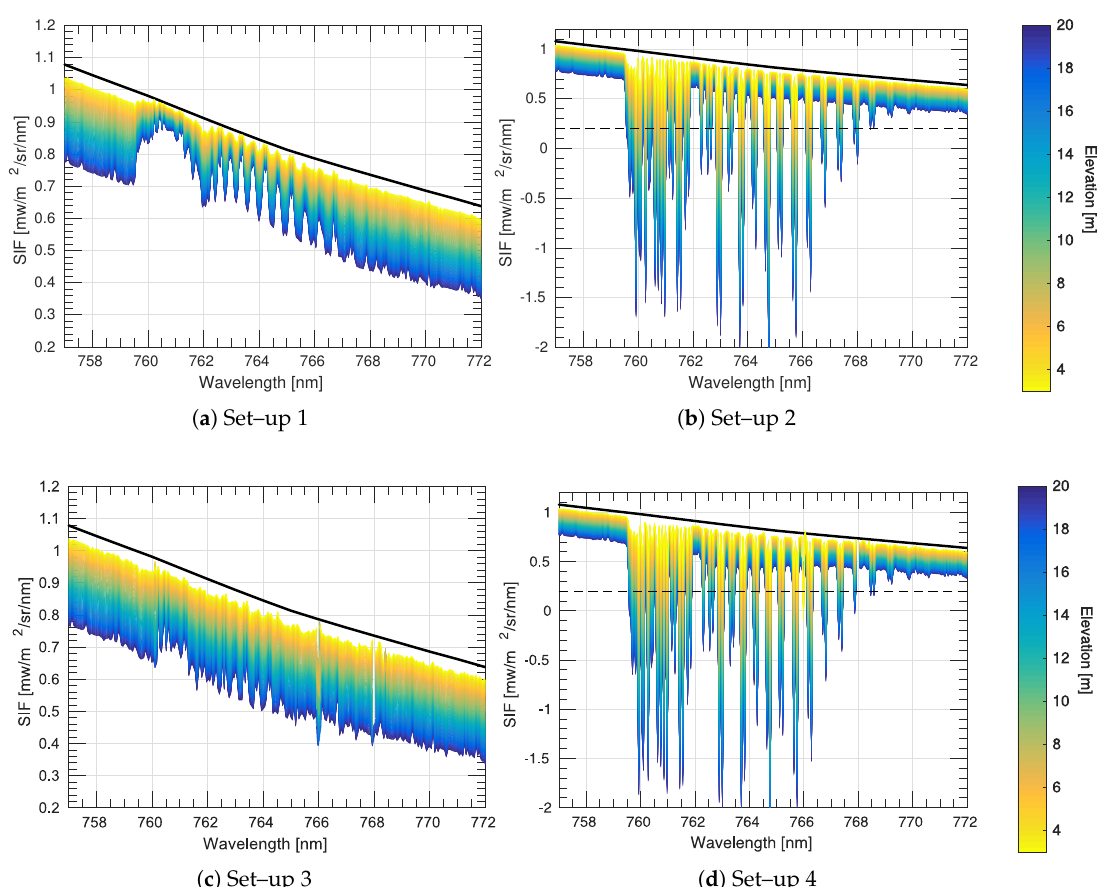
Figure 6. Retrieved SIF in the O 2 –A region under conditions configured for instrumental set–ups (1–4). Figure ( a ) Upward O 2 transmittance corrected ( t ↑ ) and solar irradiance measured at surface O 2 level ( E ); ( b ) No upward O 2 transmittance corrected and solar irradiance measured at surface level ( E ); ( c ) Upward oxygen transmittance corrected ( t ↑ ) and solar irradiance measured at sensor level ( E ); O 2 ( d ) No upward O 2 transmittance corrected and solar irradiance measured at sensor level ( E ). The black dashed line in ( b ), and ( d ) shows the lower y–axis limit set in ( a ), and ( c ) Notice that the SIF ranges vary for the panels, especially for ( a , c ) versus ( b , d